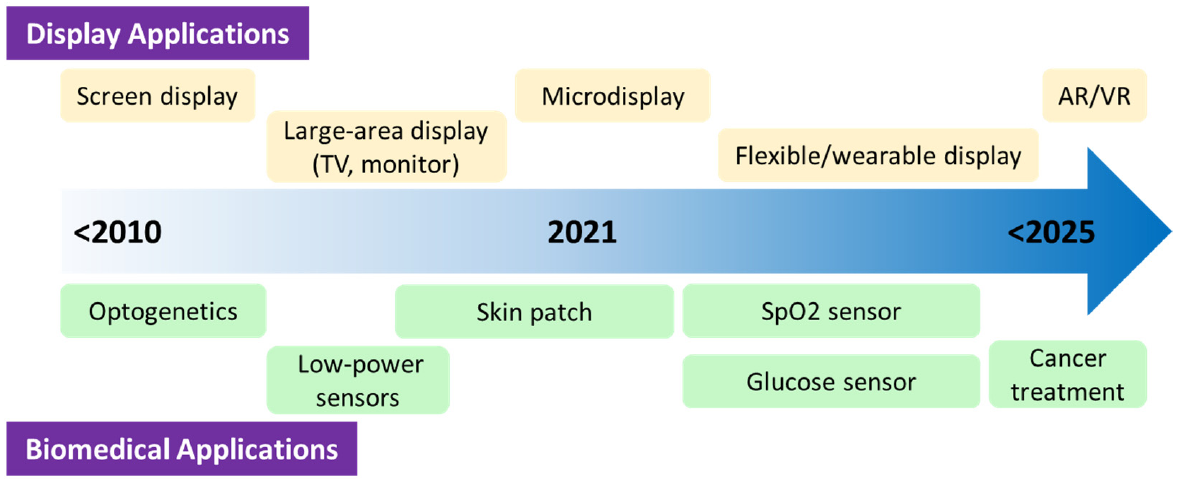
µ LEDs for display and biomedical